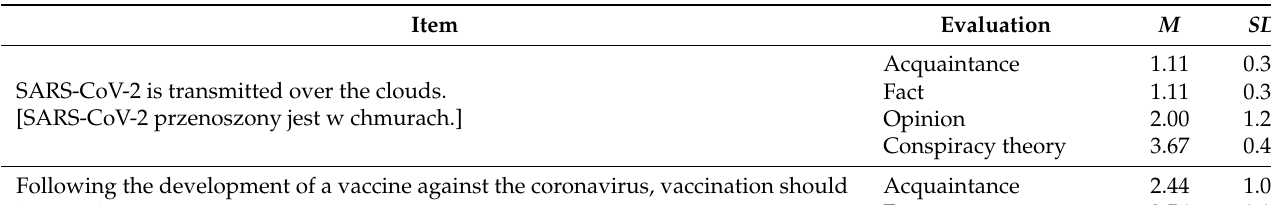
Table A1. Cont. Item Evaluation M SD SARS-CoV-2 is transmitted over the